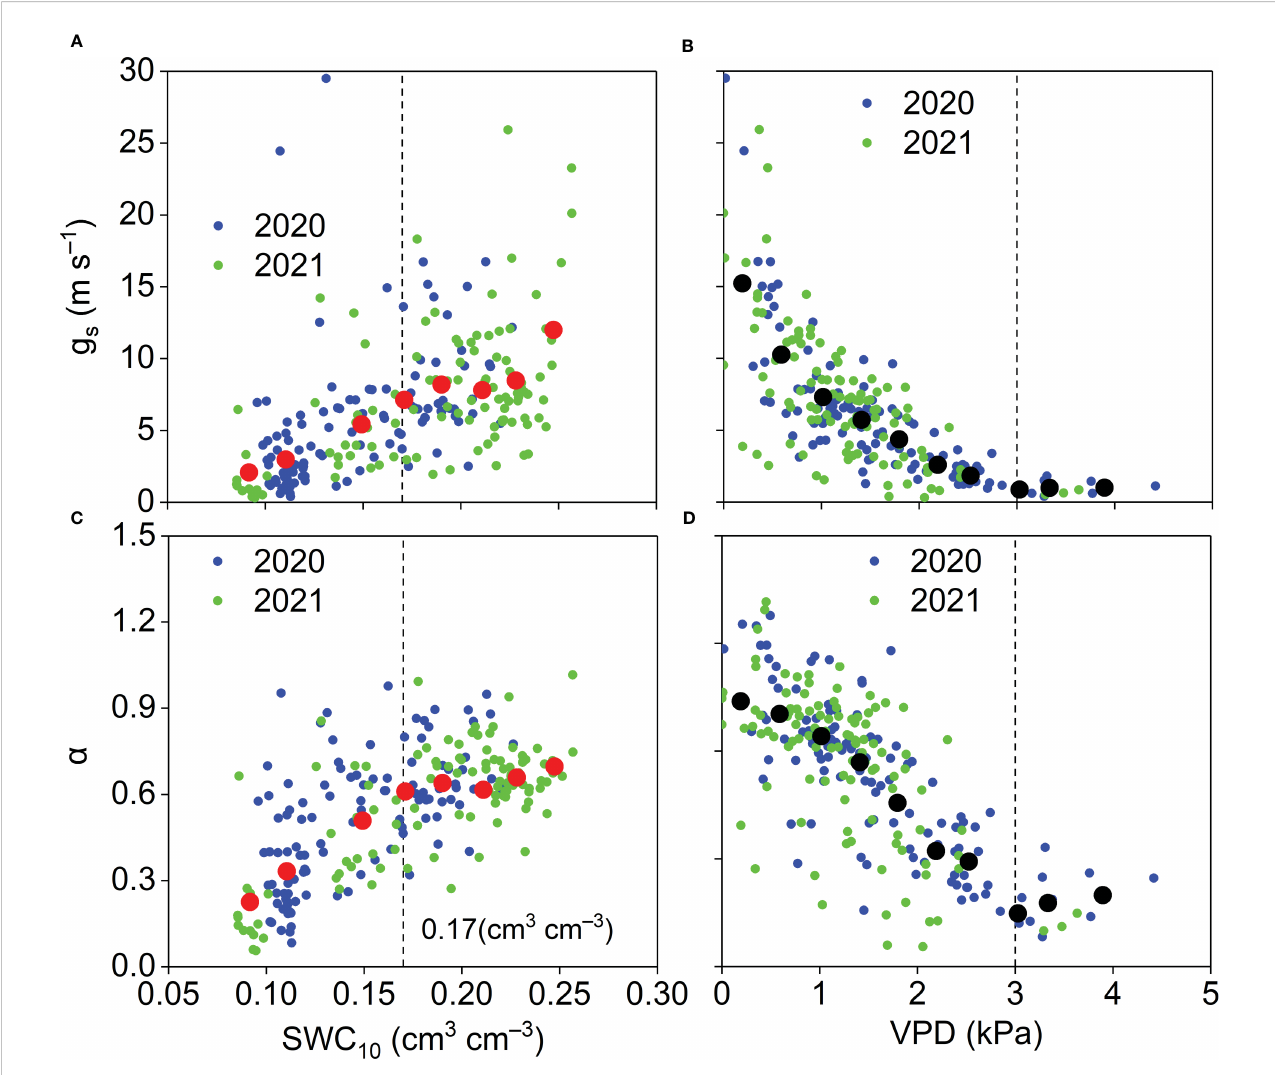
FIGURE 14 Relationships between midday (A) g s and (B) a and SWC 10 and relationships between mid-day (C) g s and (D) a and VPD and during the growing season in the Pinus tabuliformis plantation. Red solid dots: the dependent variables were bin-averaged into 0.02 cm 3 cm – 3 SWC 10 increments (A, B) . Black solid dots: the dependent variables were bin-averaged into 0.4 kPa VPD increments (C, D)